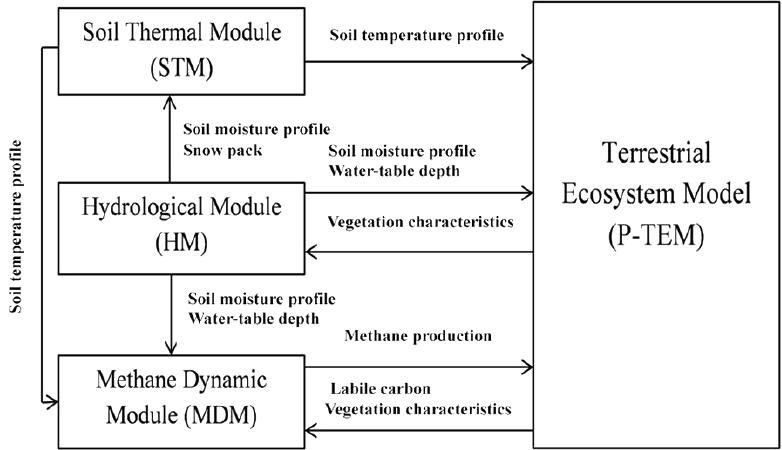
Figure 1. The P-TEM (Peatland-Terrestrial Ecosystem Model) framework includes a soil thermal module (STM), a hydrologic module (HM), a carbon/nitrogen dynamic model (CNDM), and a methane dynamics module (MDM) (Wang et al.,